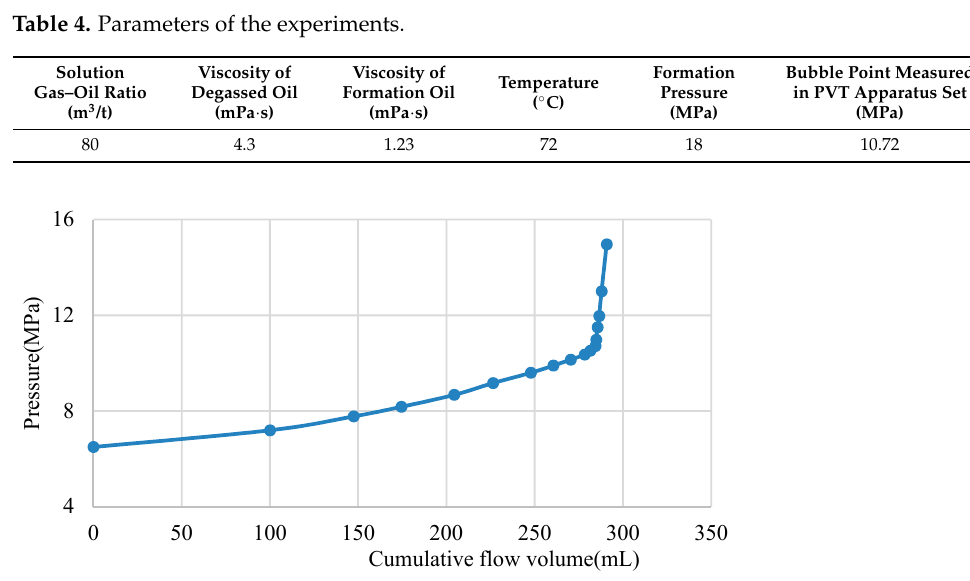
Figure 1. Bubble point pressure test curve.